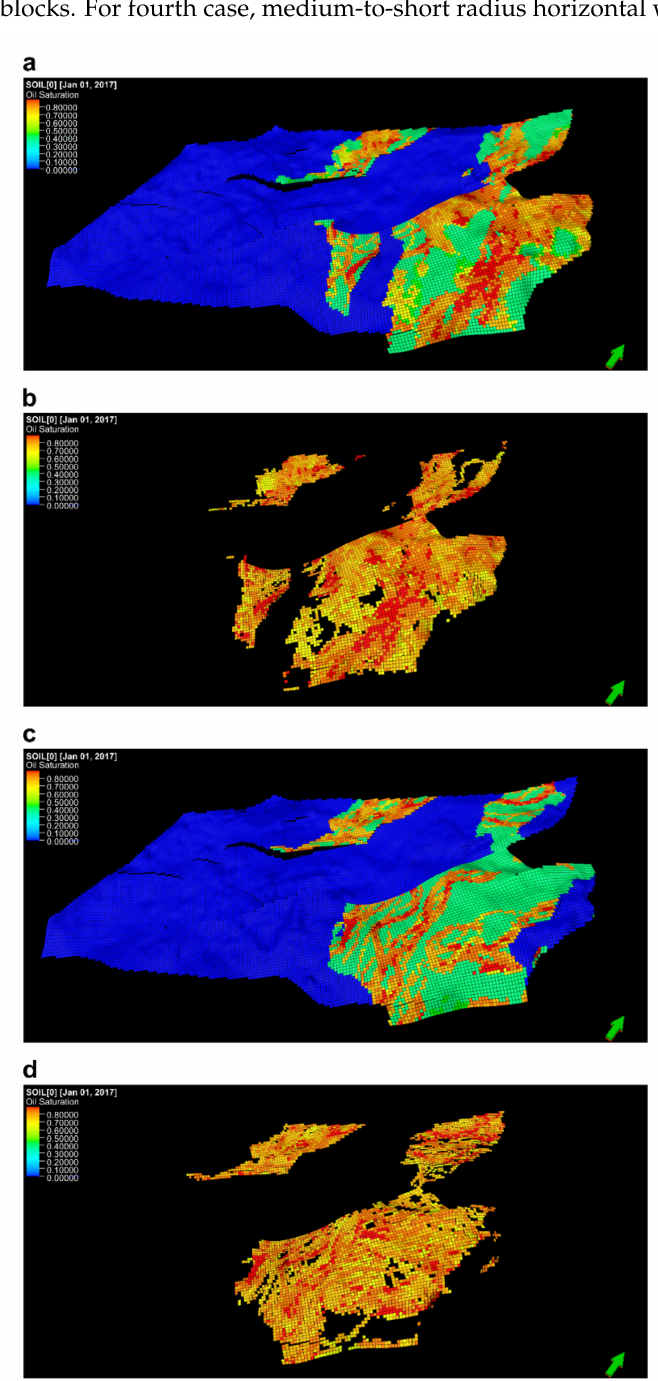
Figure 7. Hydrocarbon distribution and oil saturation (Sm 3 ) in the B27 reservoirs: ( a ) hydrocarbon saturation maps for the B27L reservoir zone; ( b ) highest oil saturation distribution map for the B27L reservoir zone; ( c ) hydrocarbon fluid saturation map for the B27U reservoir zone; ( d ) highest oil saturation map for the B27U reservoir zone. Change in color towards red indicates an increasing oil concentration; red-colored areas have the highest concentration of oil. On the contrary, change in color towards blue indicates an increase in the water